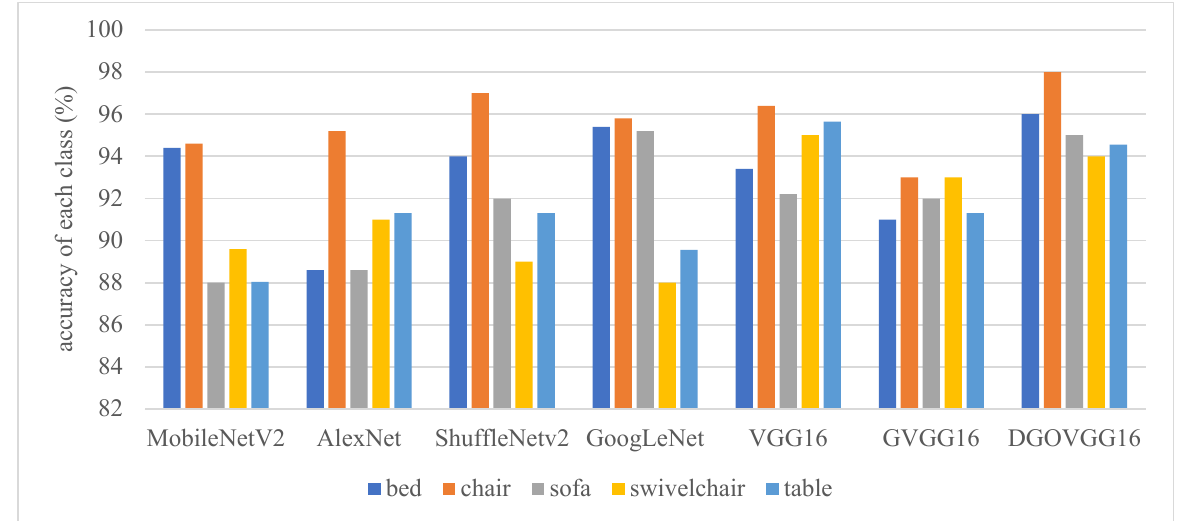
Figure 7. Classification accuracy of each class in the furniture dataset.